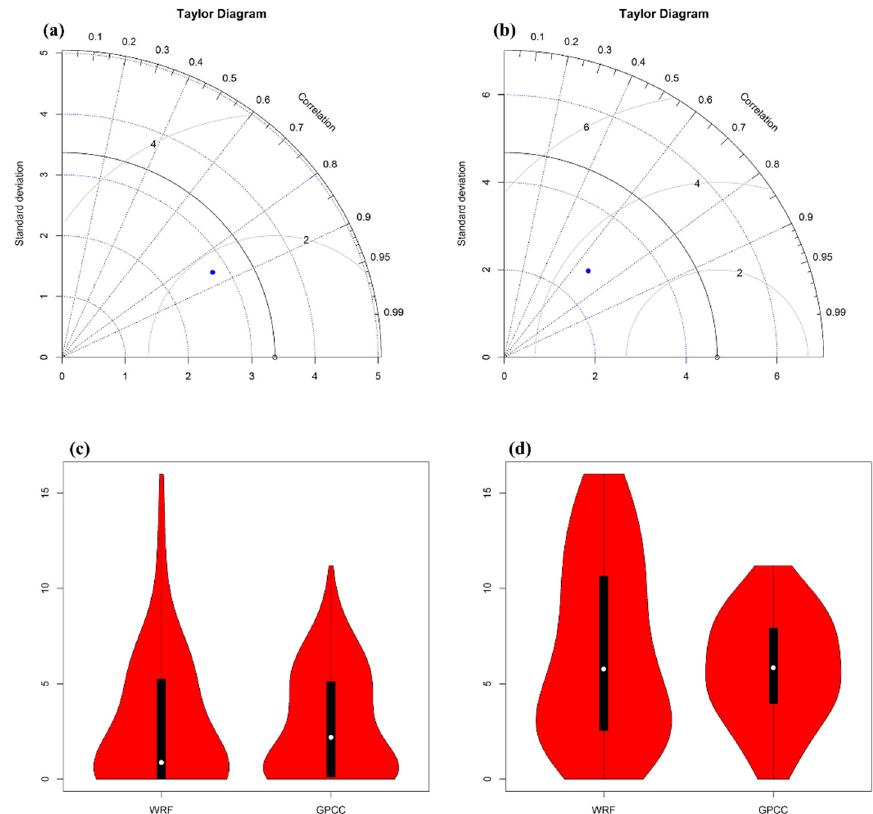
Figure 4. Taylor diagrams showing the correlation coefficients, the Root mean square error and the standard deviations of the simulated precipitation during the rainy season and those of the precipitation during the rainy season from the GPCC dataset as well as violin plots for the rainy-season precipitation over the ENB. ( a , c ): the entire domain area; ( b , d ): the Ethiopian